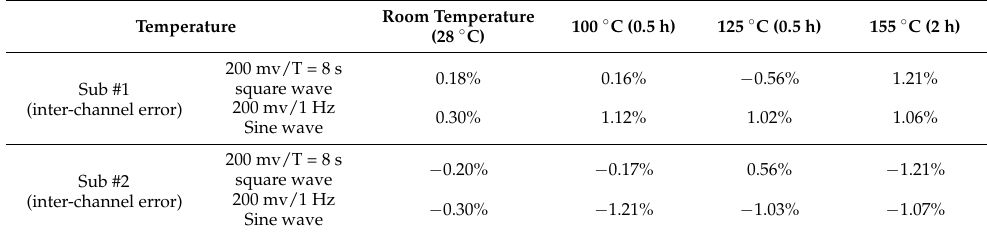
Table 3. Measurements at a high temperature (155°) (250SPS, PGA = 1).